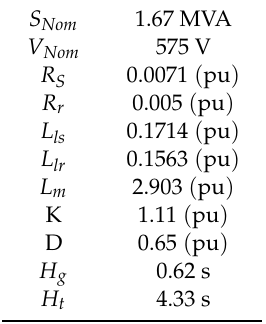
Table A2. Parameters of the